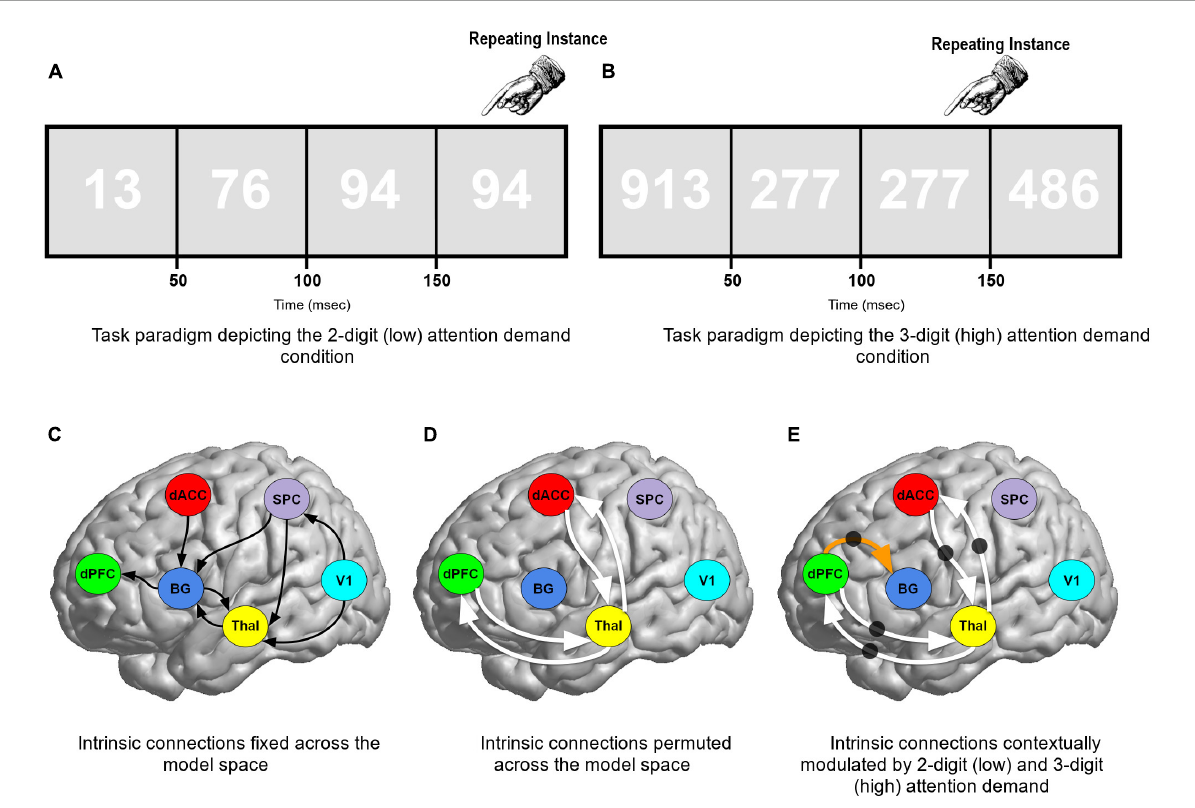
FIGURE1 (A,B) The paradigm employed and the low and high demand conditions are schematically depicted. Participants performed a continuous performance task, identical pairs version (CPT-IP), and identified repeating instances of either 2- or 3-digit numbers (blocked in 120 s epochs). The magnitude of targets constitutes a parametric manipulation of attention demands: low (2-digit) or high (3-digit) attention demand. The remainder of the figure reveals the model space used for DCM. (C) Solid (curved) black lines represent the intrinsic connections fixed across the model space. (D) Solid white lines represent cortical-thalamic intrinsic connections that were permuted across the model space. The black circles (E) denote connections which were contextually modulated by both low (2-digit) and high (3-digit) attention demand conditions. Thus, the solid white lines were permuted for both intrinsic connectivity AND contextual modulation. The dPFC → BG connection (orange arrow) was contextually modulated when the intrinsic connection was